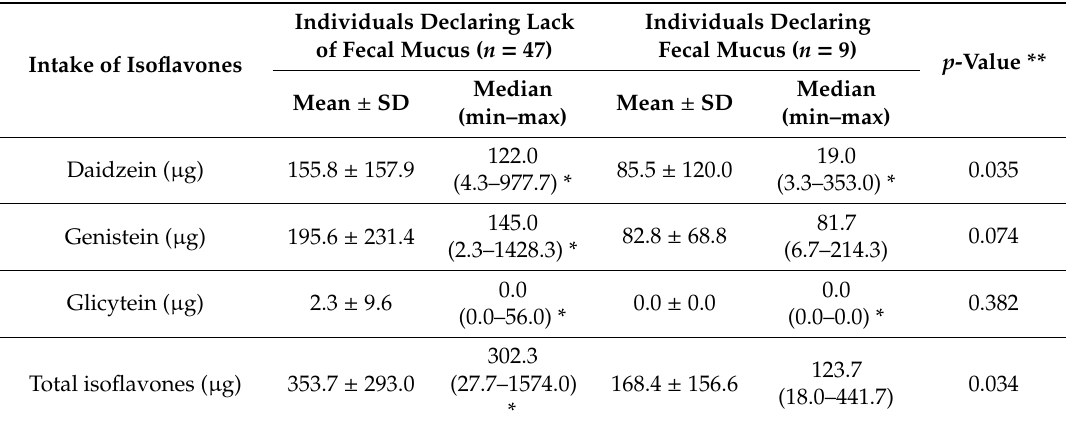
Table 4. The isoflavone intakes in groups of individuals with ulcerative colitis declaring either lack or presence of fecal mucus.